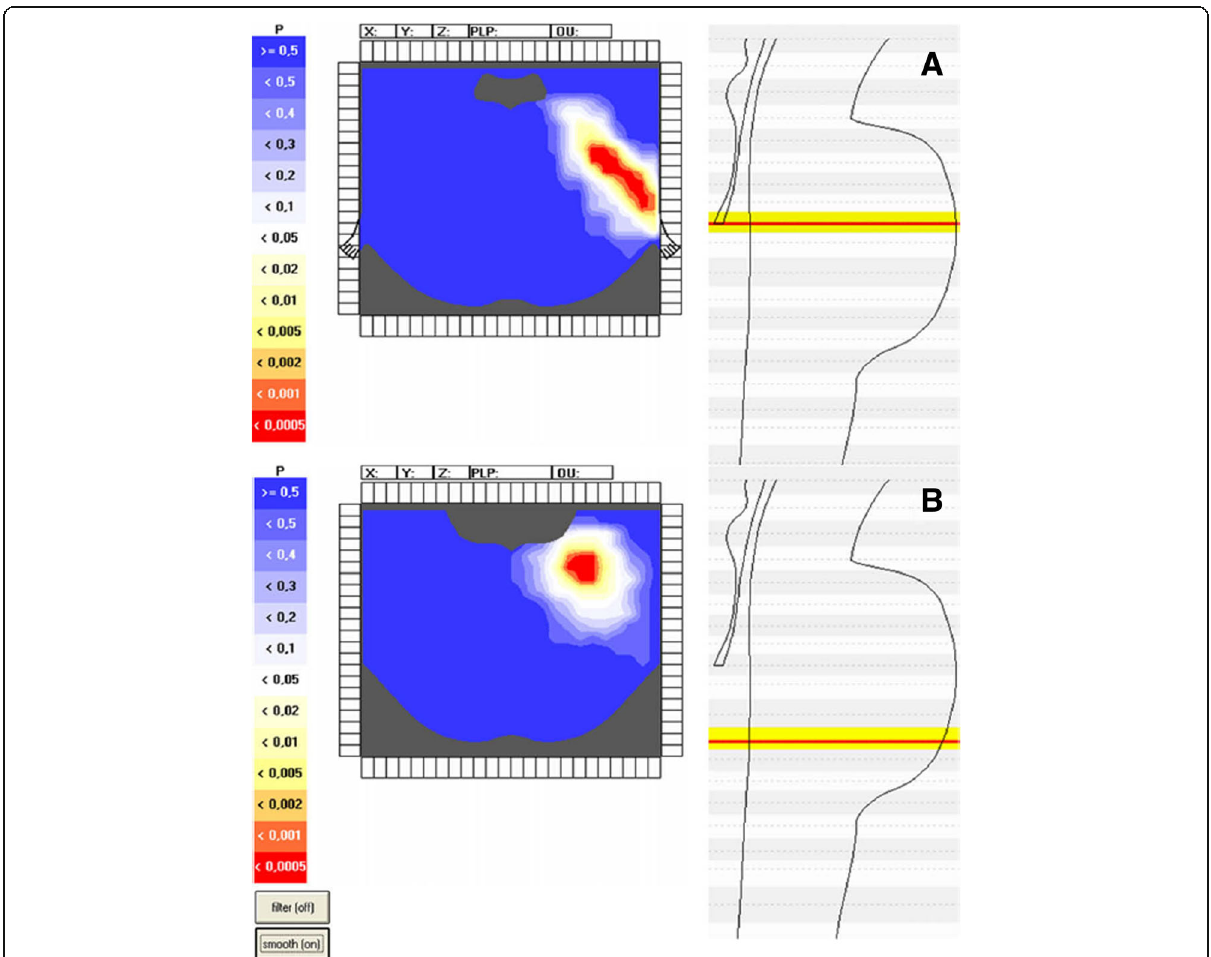
Fig. 2 Voxel-based analysis in patients with TN secondary to MS. Voxel-based brainstem model in patients with TN secondary to MS (TN group, n = 42) and in patients with trigeminal sensory disturbances due to MS (non-TN group, n =29). The statistical analysis in patients with TN secondary to MS showed an area of very high probability of a lesion ( P <0.0001) centred in the ventrolateral pons between the trigeminal root entry zone and the trigeminal nuclei, i.e. along the intrapontine part of the trigeminal primary afferents. In the non-TN group, the area of high probability of lesion ( P < 0.001) corresponded to a more caudal, medial, and dorsal pontine region involving the subnucleus oralis of the spinal trigeminal complex. The axial sections in this figure correspond to the sections 120 and 160 of the Shaltenbrandt atlas. The level of probability is colour-coded. Blue indicates non- significant areas, white the minimum level of significance ( P <0.05), and red the highest level of significance. Reproduced from